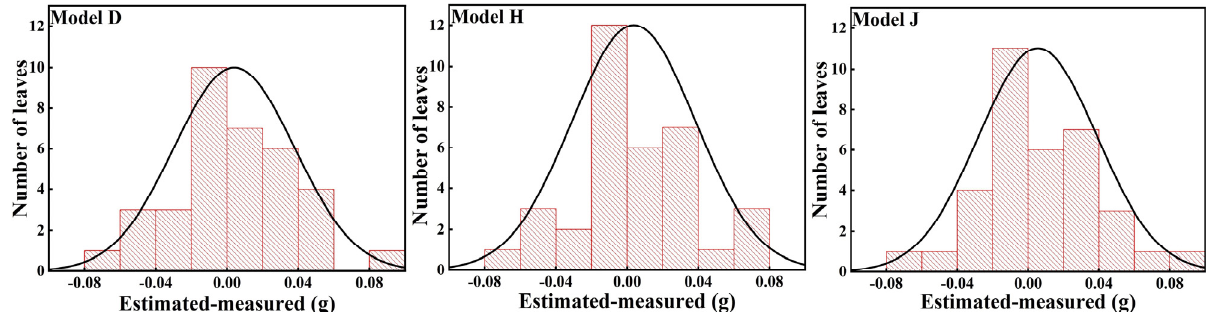
Figure 4. Error distribution in LDM estimations for Bambusa multiplex ‘ Willowy ’.